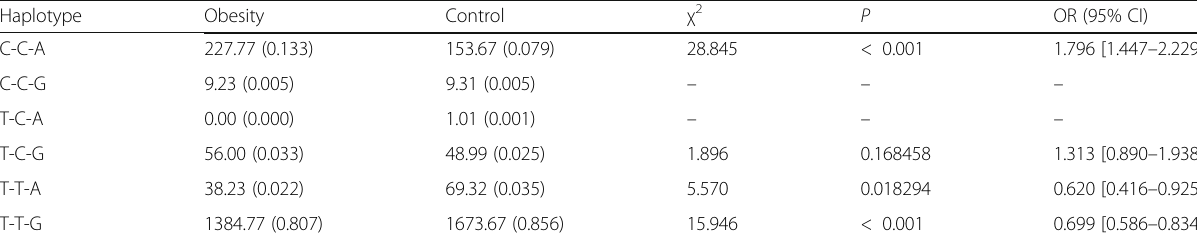
Table 4 Prevalence of haplotype frequencies in the obesity and control groups [ n (frequency)] Haplotype